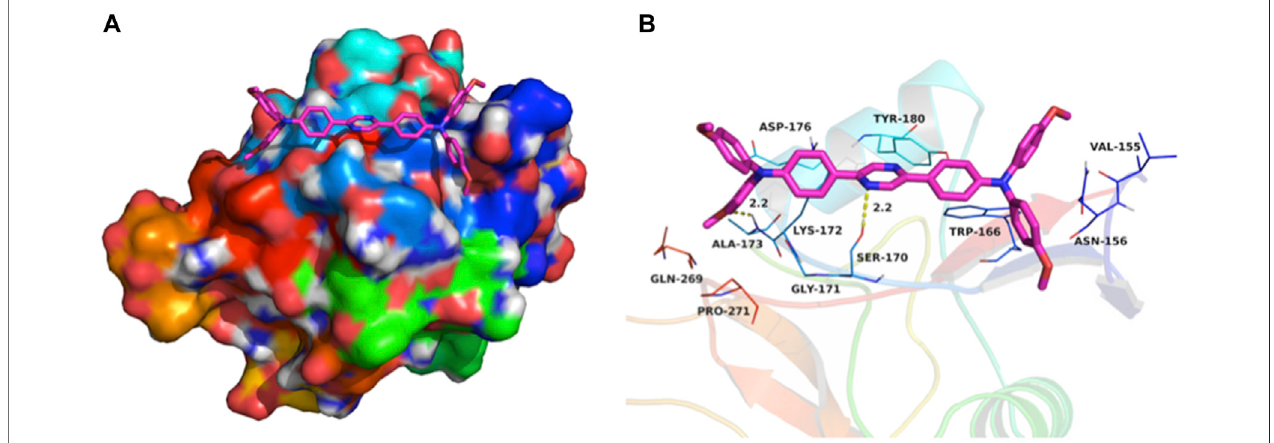
FIGURE 3 | (A) Total view of; (B) Detailed view of (OMeTPA)2Pyr docked into the binding site of the ASGPR transmembrane glycoprotein. Representative binding residues were shown in blue/green lines; the probe molecule was represented with rose red sticks with N/O atoms highlighted; The hydrogen bonds were shown in yellow dotted lines.